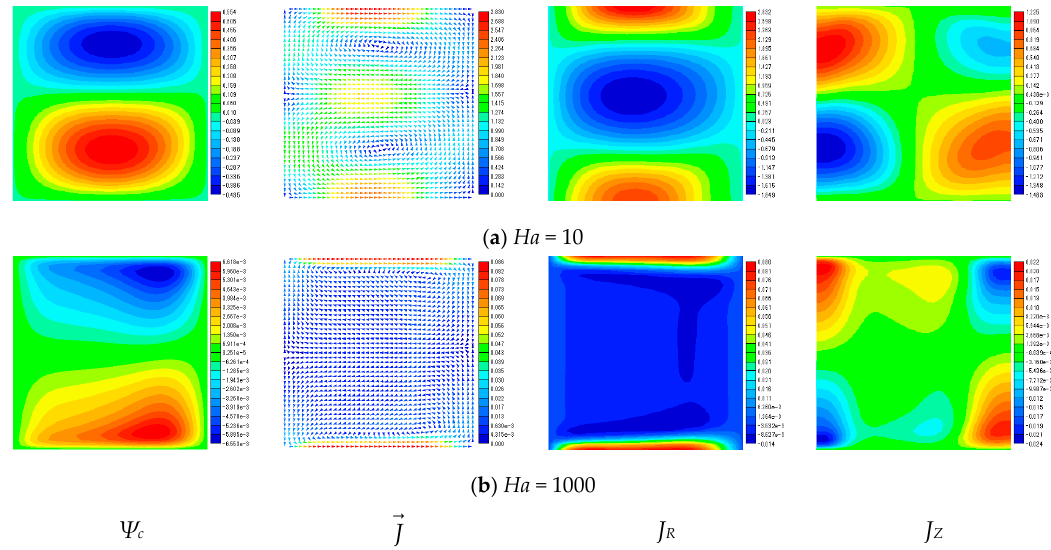
Figure 7. The contour map of streamline of electric current density Ψ c , electric current density vectors → J , radial component of electric current density J R , and axial component of electric current density J Z at Pr = 0.025, κ = 0.5, and Ra = 10 4 .